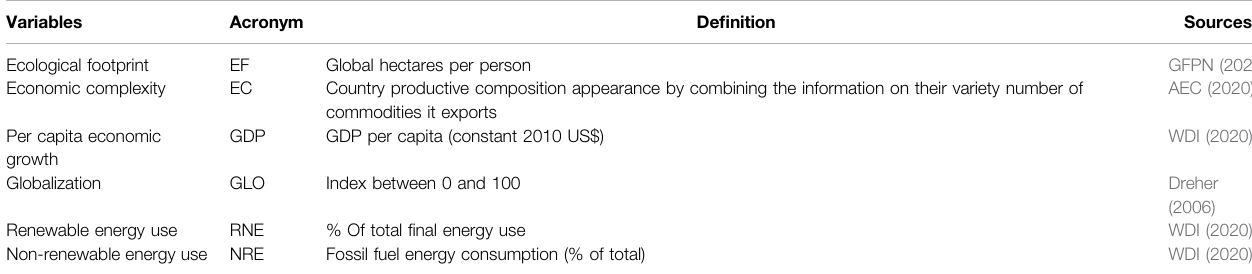
TABLE 2 | Variables description and data sources.